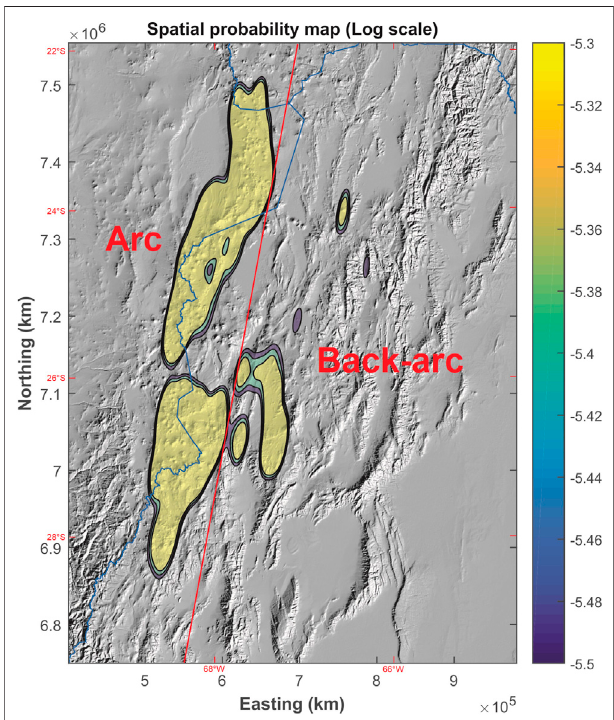
FIGURE 10 | Spatial distribution of the volcanism showing the current arc and back-arc regions. The probability isocontour 10 − 5.4 events/km 2 was used to de fi ne the boundary between these tworegions (thick red line). Figure constructed using data from Figure 3A . The political border between Chile, Argentina and Bolivia is depicted for reference (blue line). ASTER Digital elevation model used as a background image follows a greyscale colour scheme: the whiter the pixel, the higher the